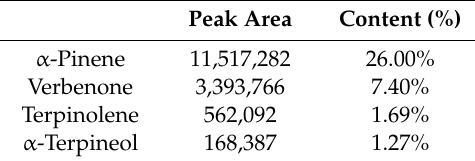
Table A1. Quantitative results of some compounds in SEO.